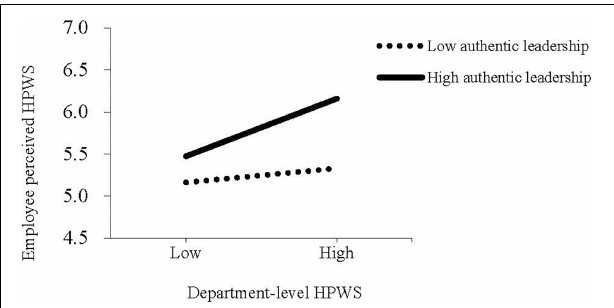
FIGURE 2 | Interaction effect of Department-level HPWS and authentic leadership on employee perceived